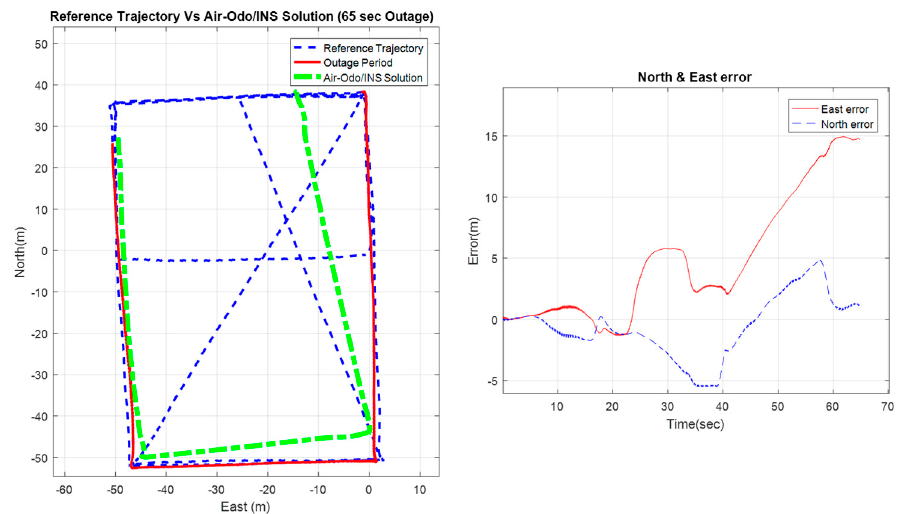
Figure 13. Air-Odo/INS integration performance during 65 seconds of complete GNSS signal outage.